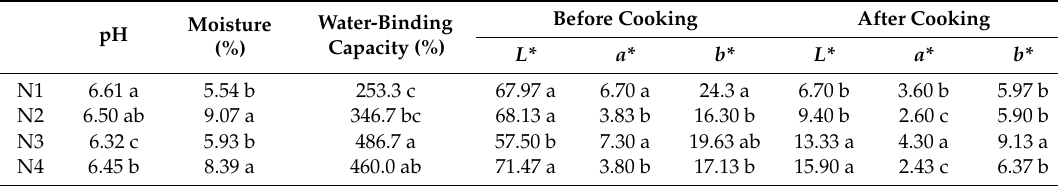
Table 2. Physiochemical properties of Nuroongji